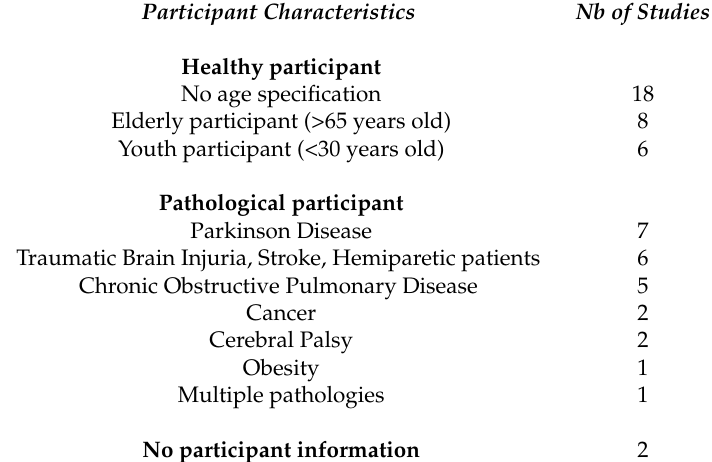
Figure 13. Detail of the number of studies according to the characteristics of included participants. Studies containing healthy participants are divided into three